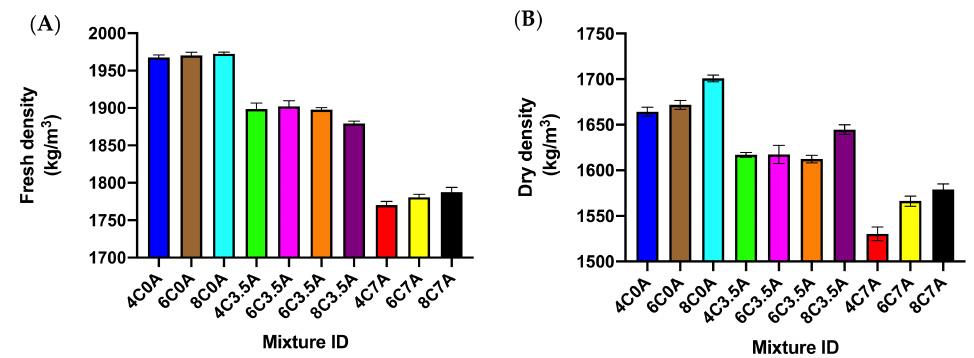
Figure 13. ( A ) Fresh density of backfill specimens and ( B ) dry density of backfill specimens cured for 28 days.